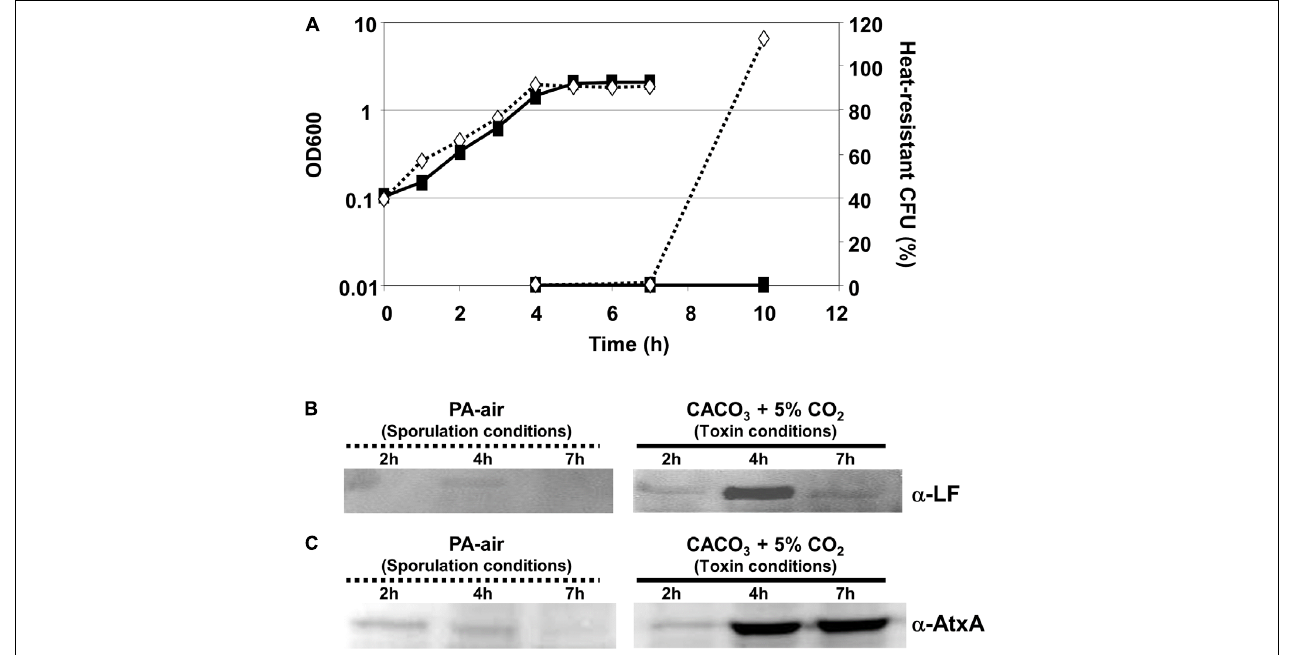
FIGURE 1 | Toxin production and sporulation are inversely related. (A) Growth curve and heat-resistant CFU determination of Ames cultured in sporulation (PA-air; hashed line/diamonds) and toxin-inducing (CACO 3 +5% CO 2 ; solid line/squares) conditions. Production of (B) LF and (C) AtxA in sporulation and toxin-inducing conditions. Cell-free supernatants for LF and cell lysates for AtxA production were obtained from early exponential (2 h), transition (4 h), and stationary (7 h) phases of growth and subjected to Western blot analysis using rabbit α -LF, and α -AtxA antibody. Protein loads were normalized to OD 600 . The data are representative of three separate